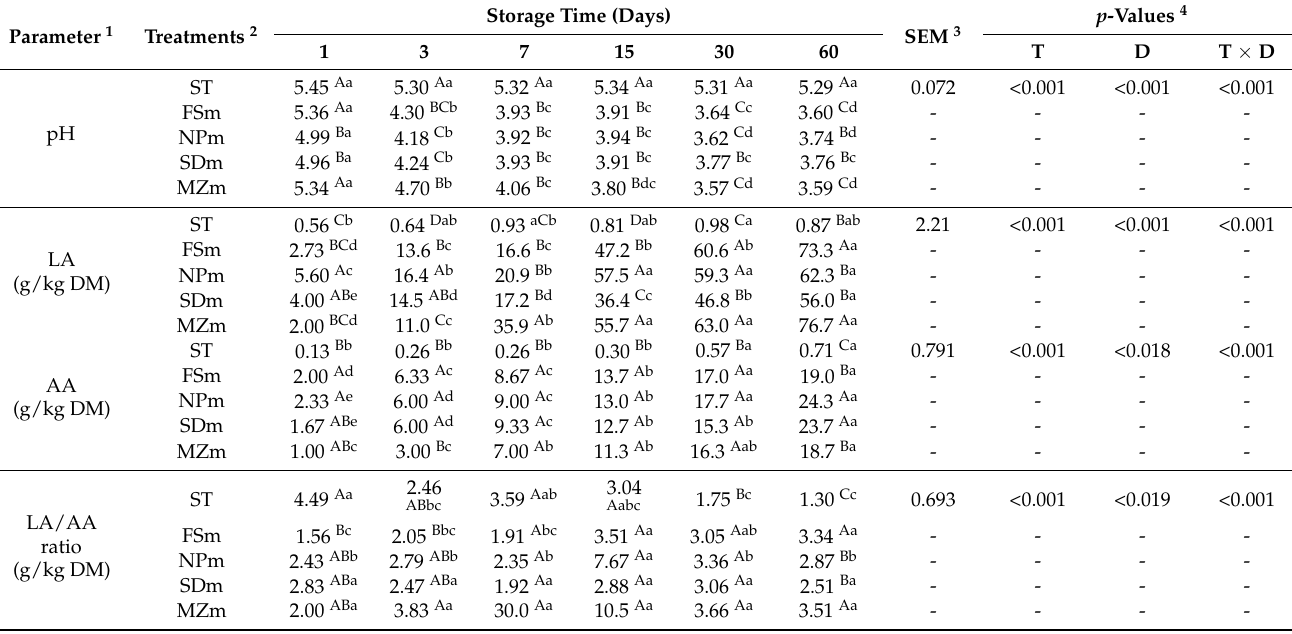
Table 2. Dynamics of the pH value and concentrations of organic acid during 60 days ensiling of forage sorghum silage.